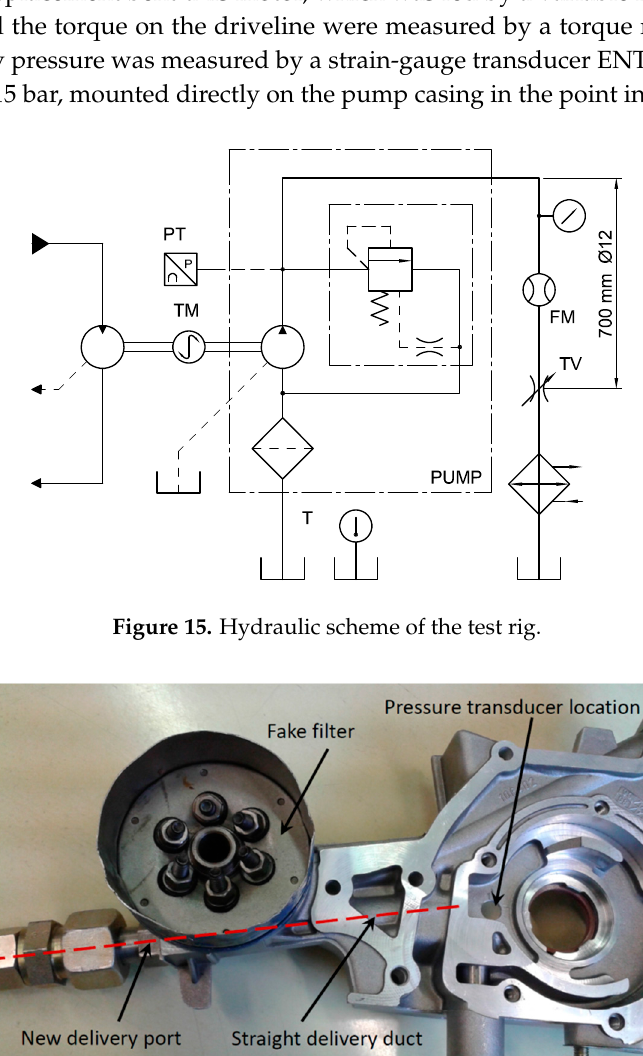
Figure 16. Photo of the pump with the connection of the delivery line.